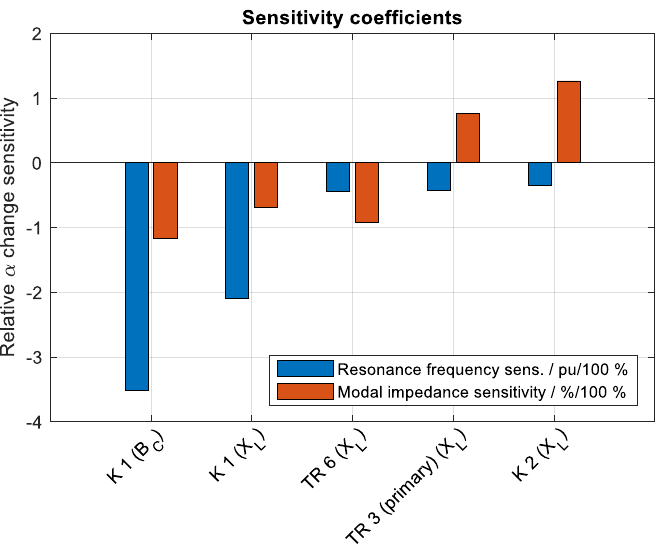
Figure 12. Resonance sensitivity coefficients of mode 5 (bus 6 is short-circuited.).